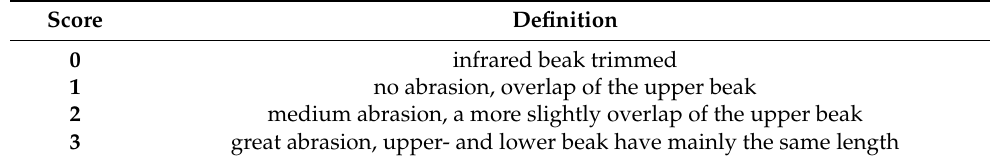
Table A8. Scoring of the beak [15].